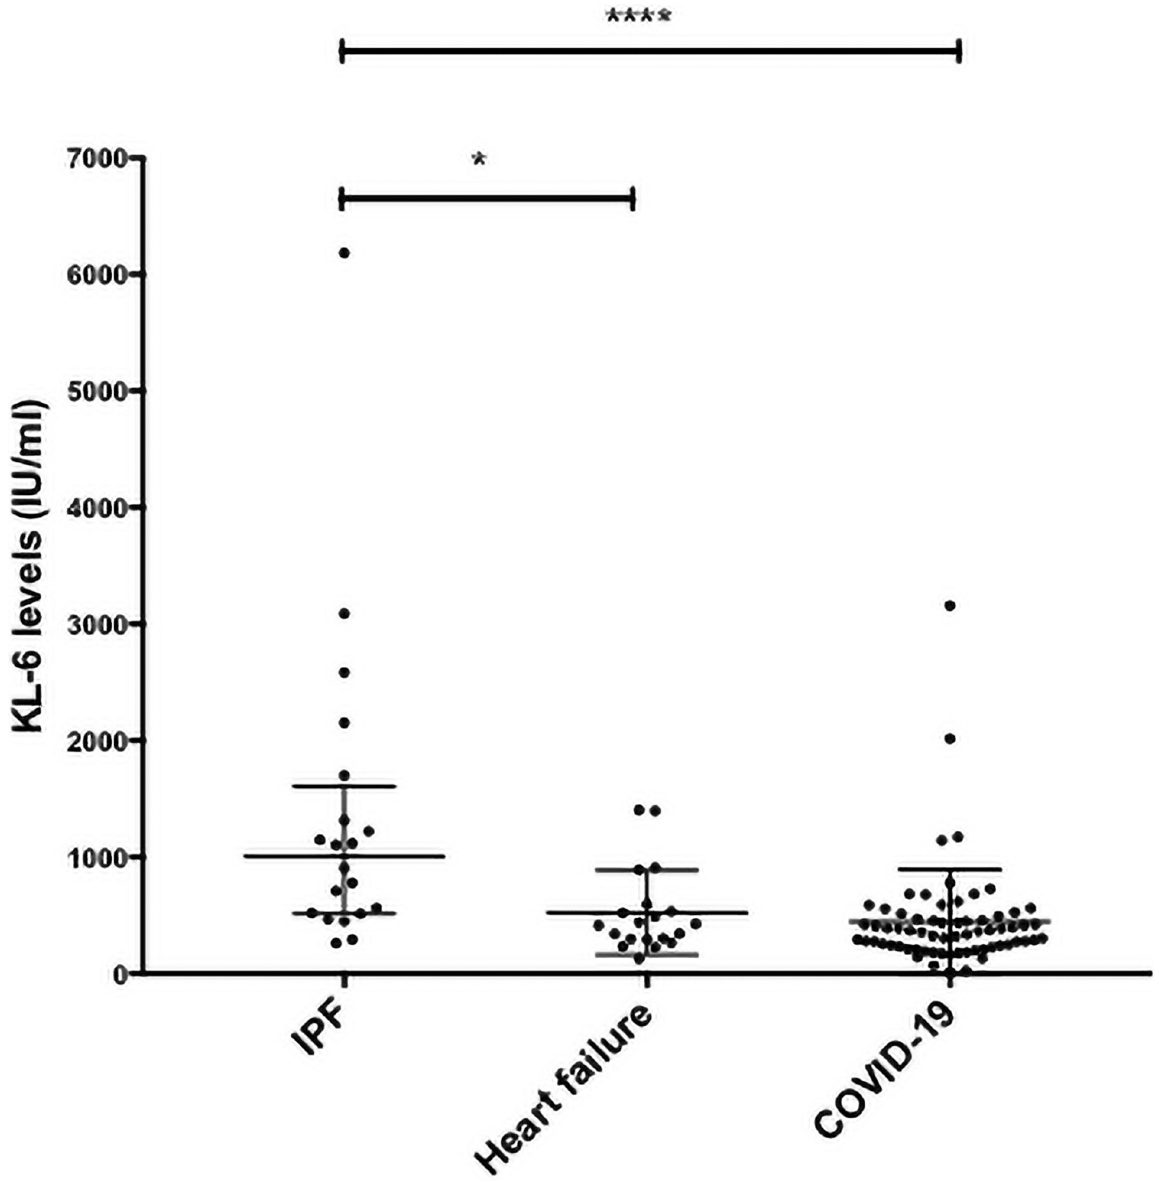
Fig 1. Serum Krebs von den Lungen (KL-6) levels in COVID-19 patients on admission compared to populations of patients with Idiopathic Pulmonary Fibrosis (IPF) and heart failure. Baseline KL-6 levels in patients with COVID-19 were comparable to those measured in a cohort of heart failure patients but statistically lower than serum levels measured in a mild to moderate cohort of IPF patients (baseline KL-6 COVID-19 365IU/ml (IQR 233–493) n = 67, heart failure 419 IU/ml (IQR 294–581) n = 20, IPF 1005 (IQR 514–1604 IU/ml) n = 20, Kruskal-Wallis � p < 0.05, ���� p <